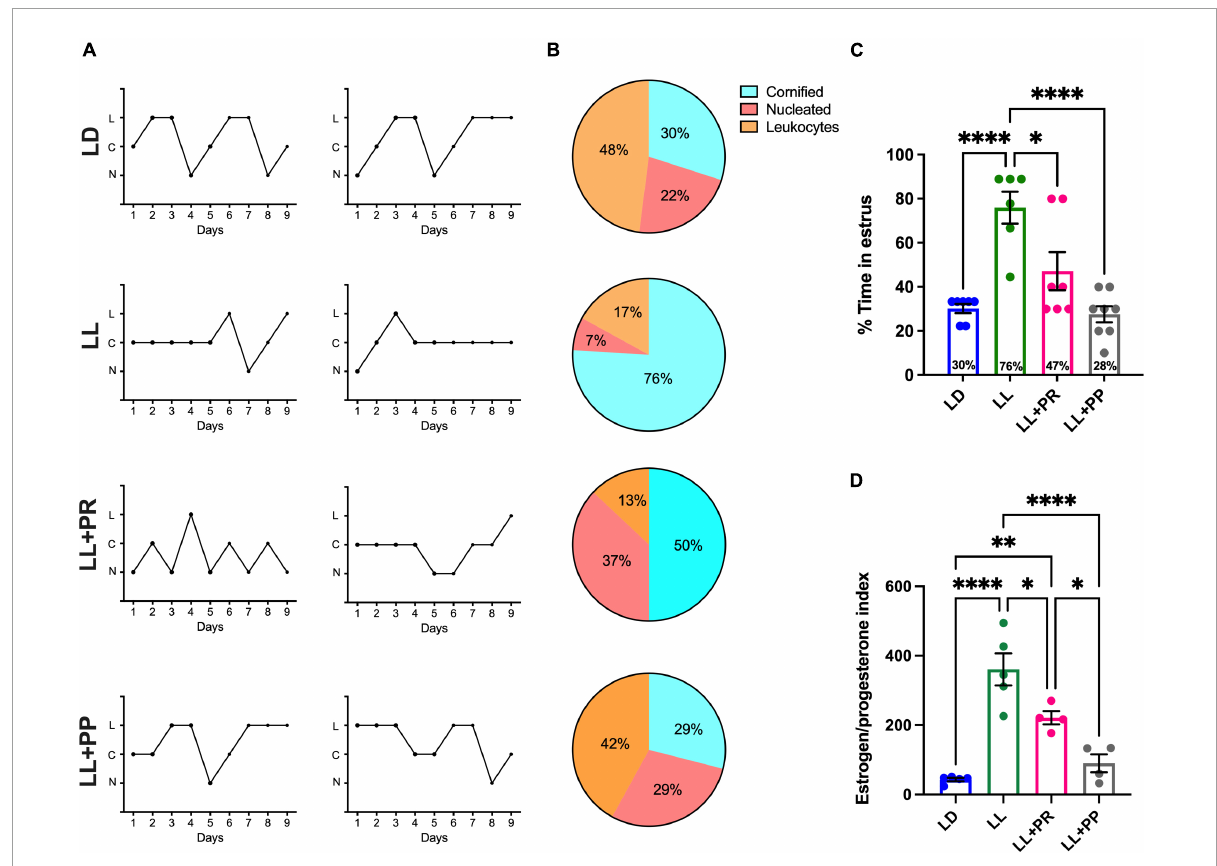
FIGURE8 Estrous cycles obtained by 9-day vaginal smears. (A) Two representative cycles obtained with the cytology in the vaginal smears of rats exposed to a light–dark cycle during the baseline (BL, blue lines, and bars), to constant light (LL, green lines and green bars), to LL followed by 3 weeks of 12-h feeding protocol distributed in four pulses feeding events every 3 h as a rescue strategy (LL + PR, pink), or to LL simultaneously to four food pulses as a preventive strategy for 6 weeks (LL + PP). (B) Percentage of rats showing predominance for a given cellular type at each day of the estrous stage according to vaginal cytology. (C) Proportion of days in which rats displayed estrus. (D) Estrogen/progesterone (E 2 /P) ratio. Data are expressed as the mean ± SEM; n = 4–5/group. Asterisks indicate * P < 0.05, ** P < 0.01; **** P < 0.0001. C, cornified cells; L, leukocytes; N, nucleated